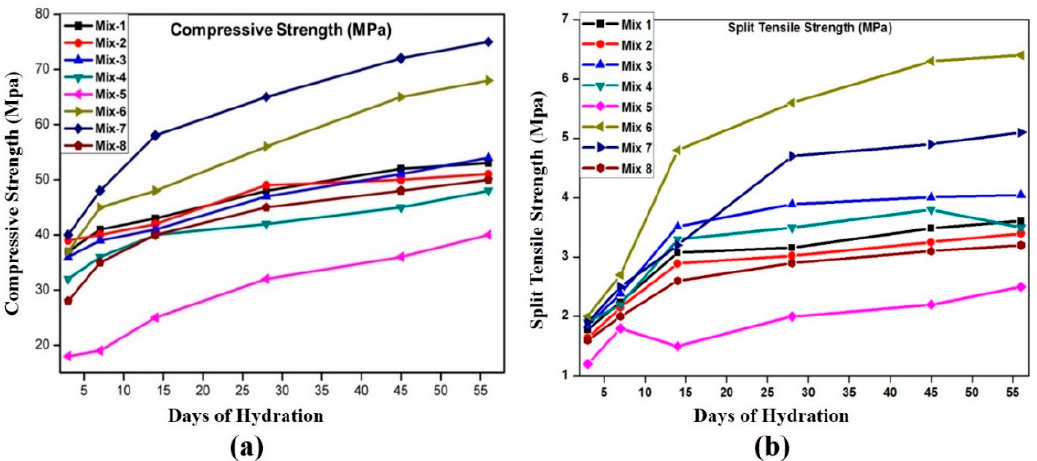
Figure 9. ( a ) Compressive and; ( b ) split tensile strengths of mortars.